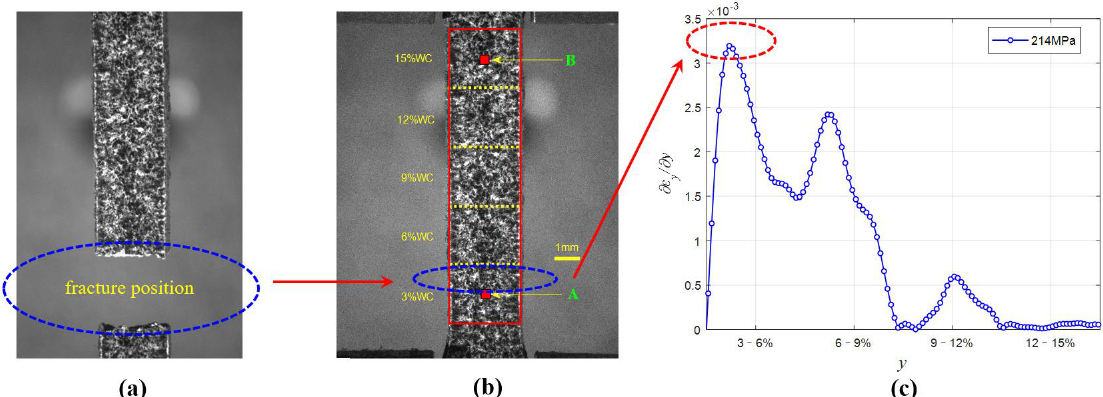
Figure 10. Schematic diagram of specimen fracture location. ( a ) Fracture morphology of specimen; ( b ) Fracture position of specimen; ( c ) Strain rate curve in y direction when the stress is 214MPa.